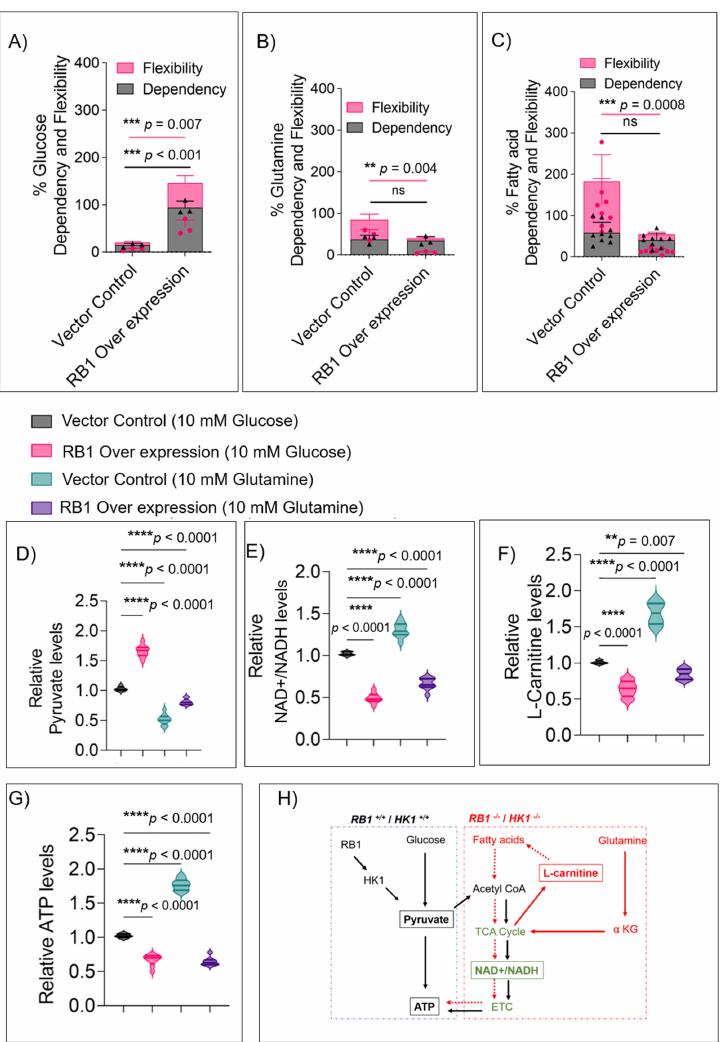
Figure 5. RB1 expression restricts the usage of alternate fuels. Seahorse XFp Mito-fuel flex as- says to measure fuel dependency and flexibility in cells transduced with different vectors as indi- cated. ( A ) Oxidation of glucose as fuel in control and RB1 -complemented WERI-Rb1 cells ( n = 3). ( B ) Oxidation of glutamine as fuel ( n = 3). ( C ) Oxidation of fatty acids as fuel ( n = 3). Validation of fuel oxidation profile in cells cultured in glucose and glutamine alone conditions and transduced with indicated vectors. Measurement of key metabolites was assessed as follows: ( D ) pyruvate levels indicating glycolytic flux, ( E ) NAD+/NADH ratios to estimate mitochondrial TCA functions, ( F ) L-carnitine levels to evaluate dependency on fatty acid oxidation. ( G ) Total ATP levels to estimate energy produced. ( H ) Schematic representation of metabolites in each metabolic pathway under RB1 null and RB1- overexpressed cells. Values represent the mean ± s.d. of three independent experiments. Two-tailed Mann–Whitney test (for 2 groups) or Kruskal–Wallis with Dunn’s multiple comparisons test (for >2 groups) were used for statistical analysis. ** p < 0.01, *** p < 0.001, **** p <